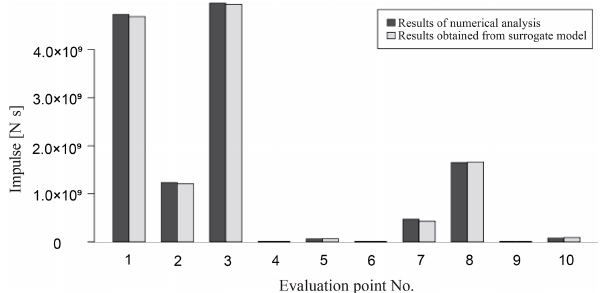
Figure 17. Comparison of impulses calculated from the results of numerical analysis and the results reconstructed by using spatial